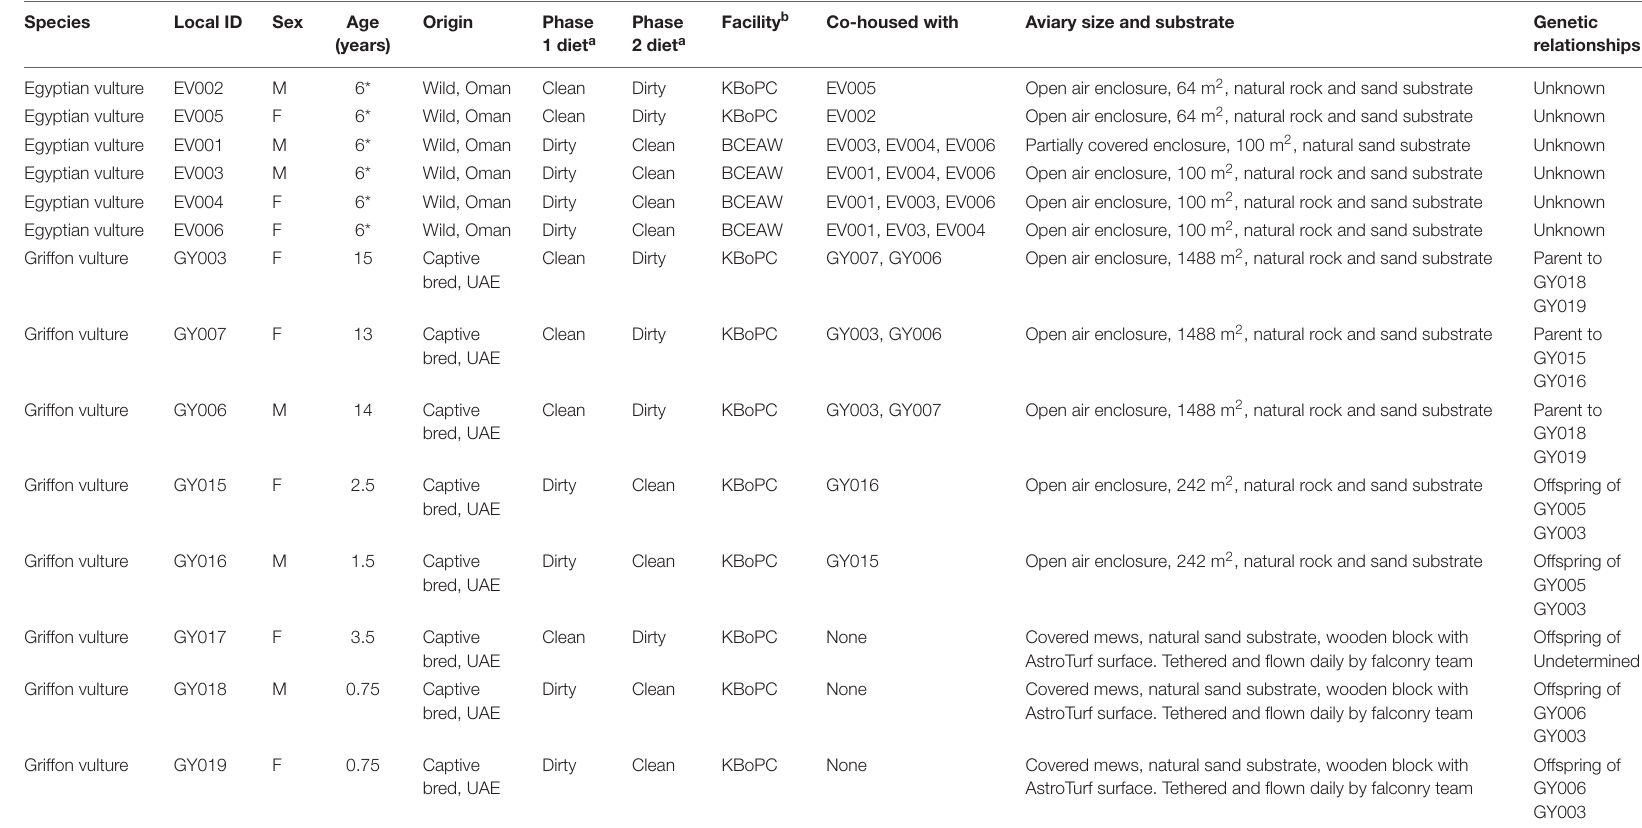
TABLE 1 | Vulture details, diet, and housing conditions at the time of study.